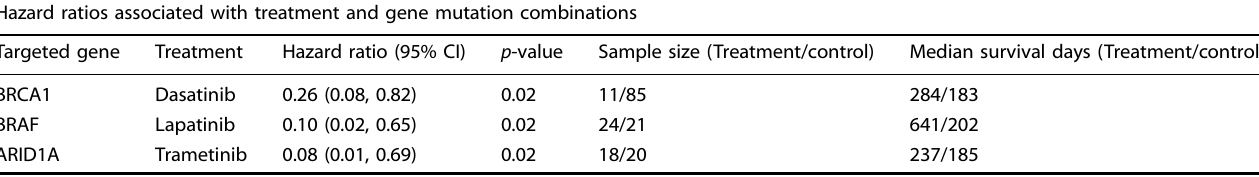
Table 3. Hazard ratios associated with treatment and gene combination, con fi dence intervals, p -values, sample sizes, and MST. Hazard ratios associated with treatment and gene mutation combinations Targeted